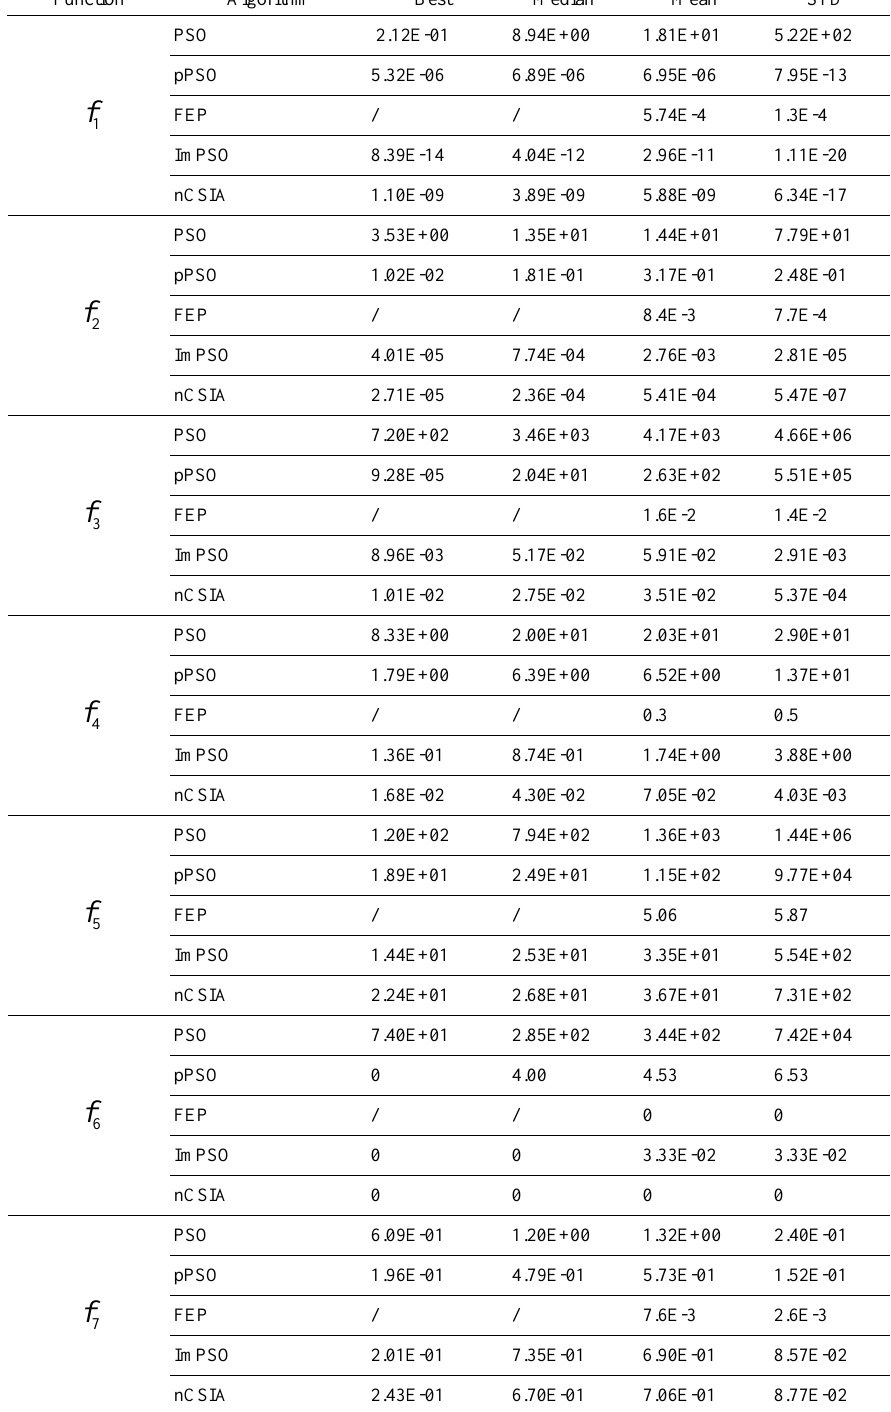
Table 2. Results comparison among PSO, pPSO, FEP, ImPSO, nCSIA for high dimensional unimodal functions. “/” means the item not